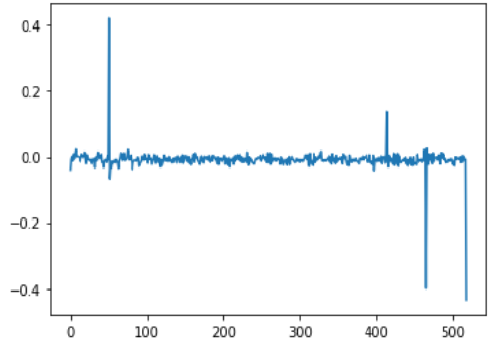
Figure 58. Merged gyroscope data visualization.